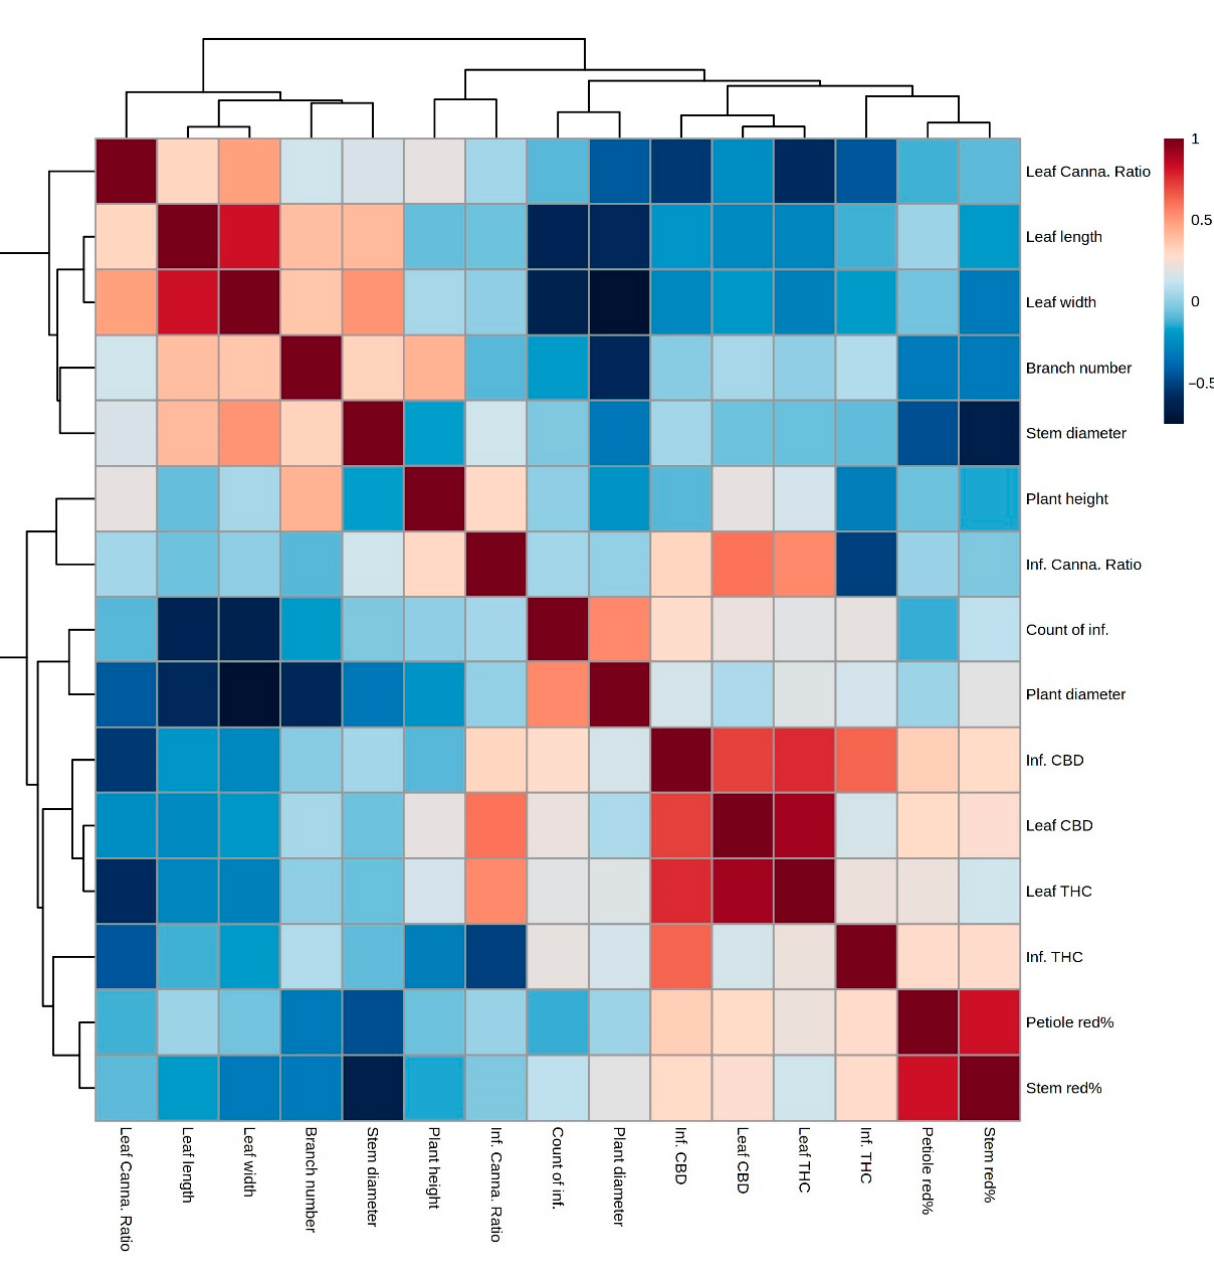
Figure 5. Heat map of Pearson’s correlation coefficient matrix between morphological and chemotype. The color scale indicates the intensity of correlation (red is directly proportional, blue is inversely proportional). All cannabinoids included acidic precursors.